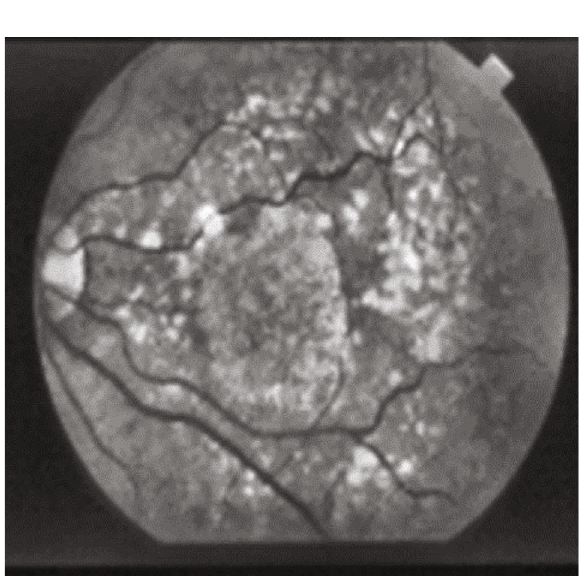
Figure 5: Enhanced